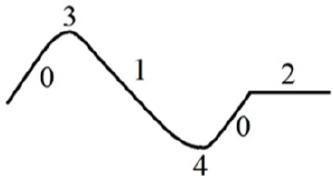
Figure 3. Symbolization of a spectral curve. (Ascending segment: 0, descending segment: 1, flat segment: 2, and peak and valley of the spectral curve: 3 and 4, respectively).